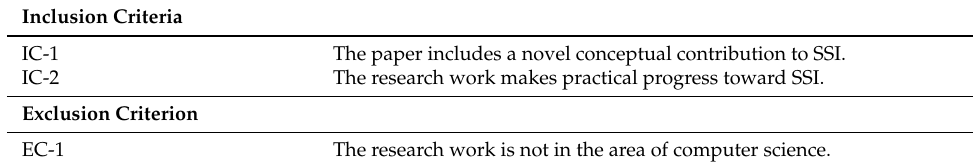
Table 2. Inclusion and exclusion